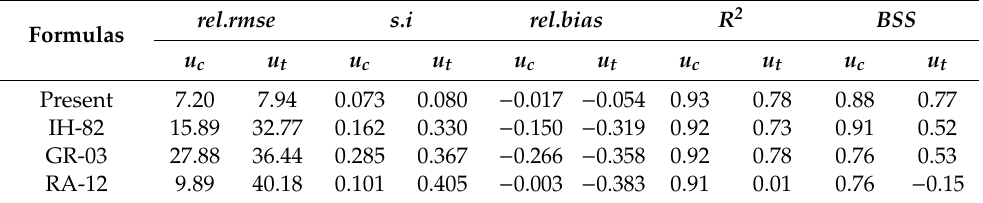
Figure 11. Comparison between computed peak onshore ( a ) and peak offshore ( b ) orbital velocity obtained by the studied formulas and measurements for test B1 and B2. Table 4. Quantitative assessment of formula performances for the GR99 data.